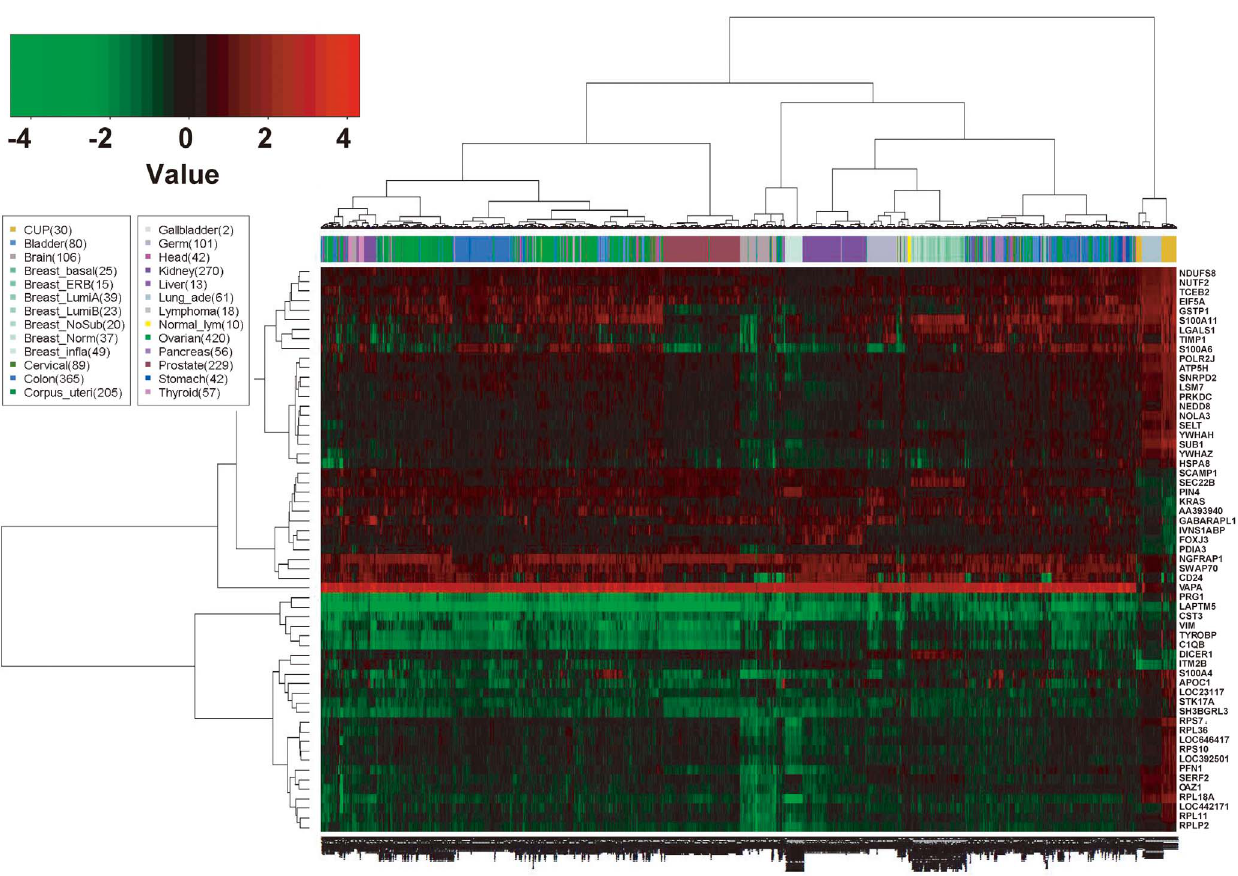
Figure 2. Heatmap representing the expressions of 59 genes with significant different expression in CUP compared with other cancer types or normal lymph nodes. Genes are indicated on the right. The colored bar above the heatmap represents the different cancer types, and the legend key is on the left. On the heatmap, red represents up-regulated genes and green represents down-regulated genes, relative to the expression levels in normal lymph nodes, with the scale shown in the upper left corner. The gene expression profiling datasets for normal lymph nodes and 24 known cancer types other than CUP were obtained from publicly available sources, as described in the Materials and Methods.